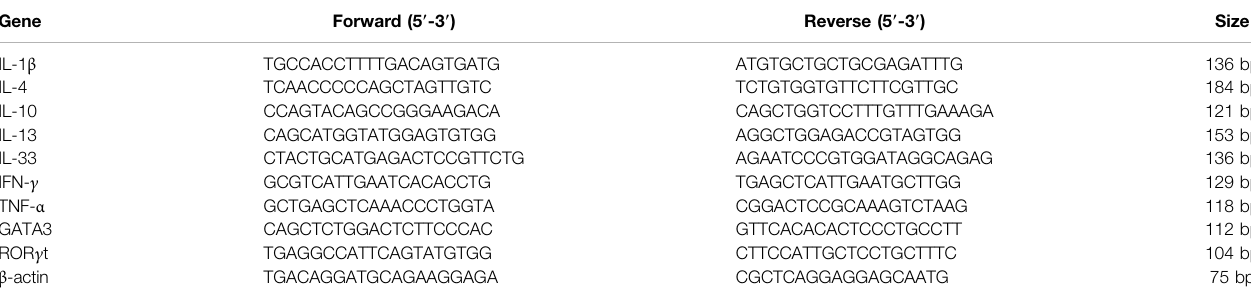
TABLE 1 | Sequences of qPCR primers.